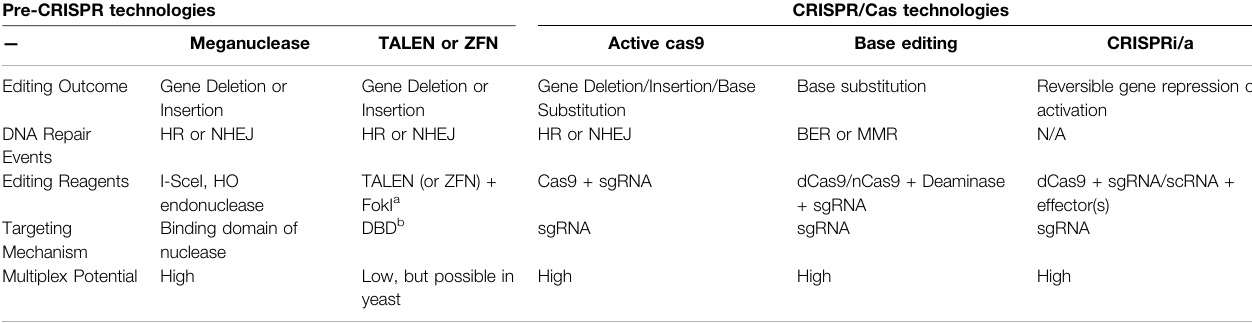
TABLE 1 | Overview of Genome Editing Technologies.